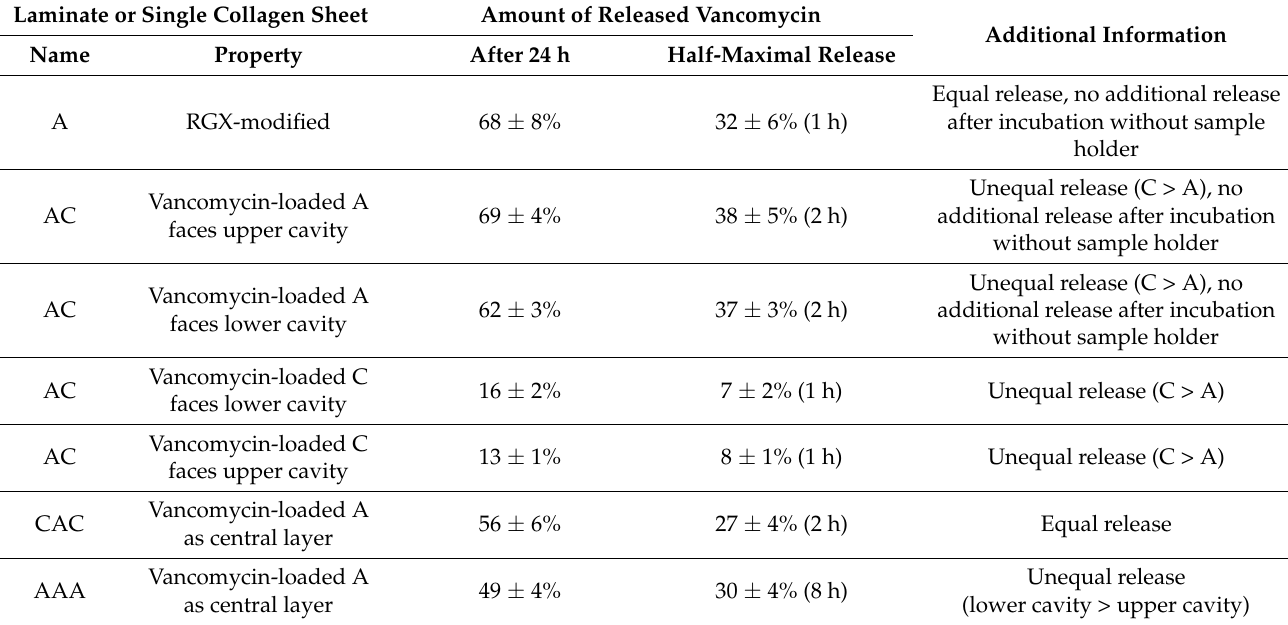
Table 1. Overview of the results from vancomycin release experiments. The name of each laminate or single collagen sheet refers to its composition, as the laminates are composed of single sheets of Atelocollagen (A) and/or Collagen Solutions (C). Laminate or Single Collagen Sheet Amount of Released Vancomycin